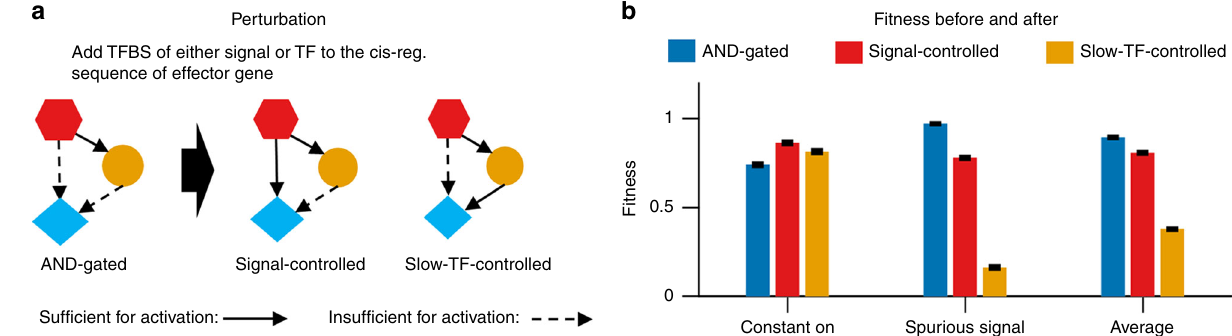
Spurious signal AverageInsufficient for activation:Sufficient for activation: